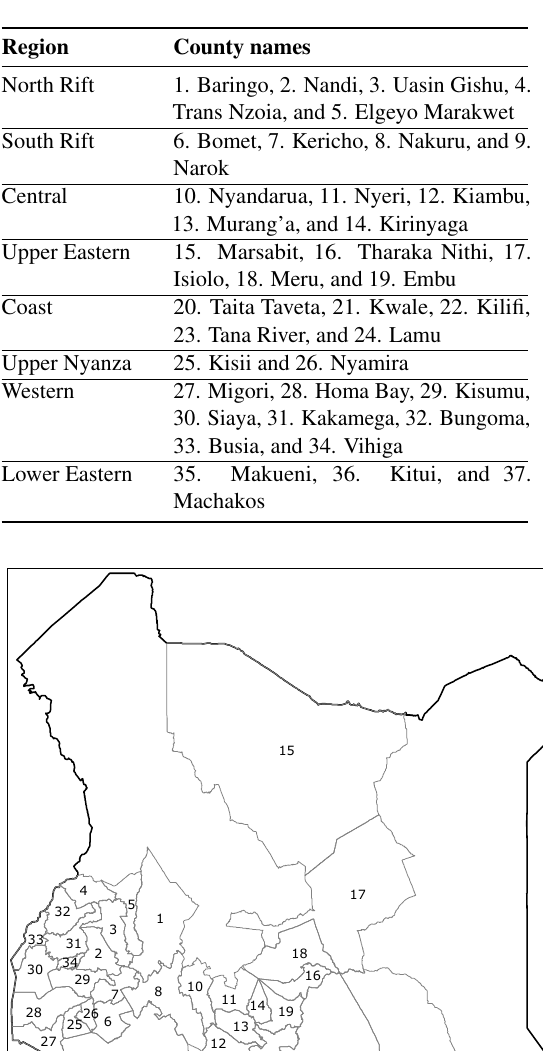
Table 1. Grouped maize growing counties in Kenya.